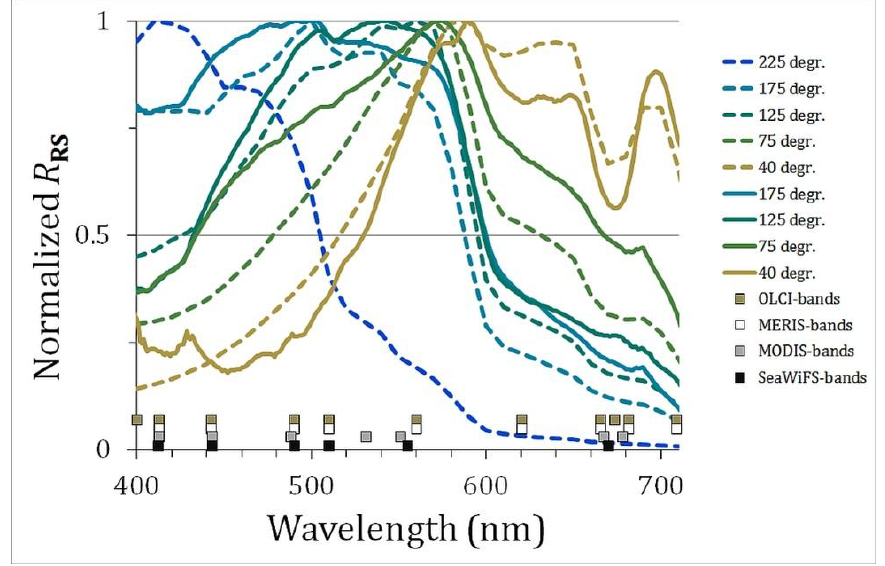
Figure 3. Example of synthetic (full lines) and field (dashed lines) spectra with hue angles varying between 225° and 40°. Spectral satellite bands are given for OLCI, MERIS, MODIS and